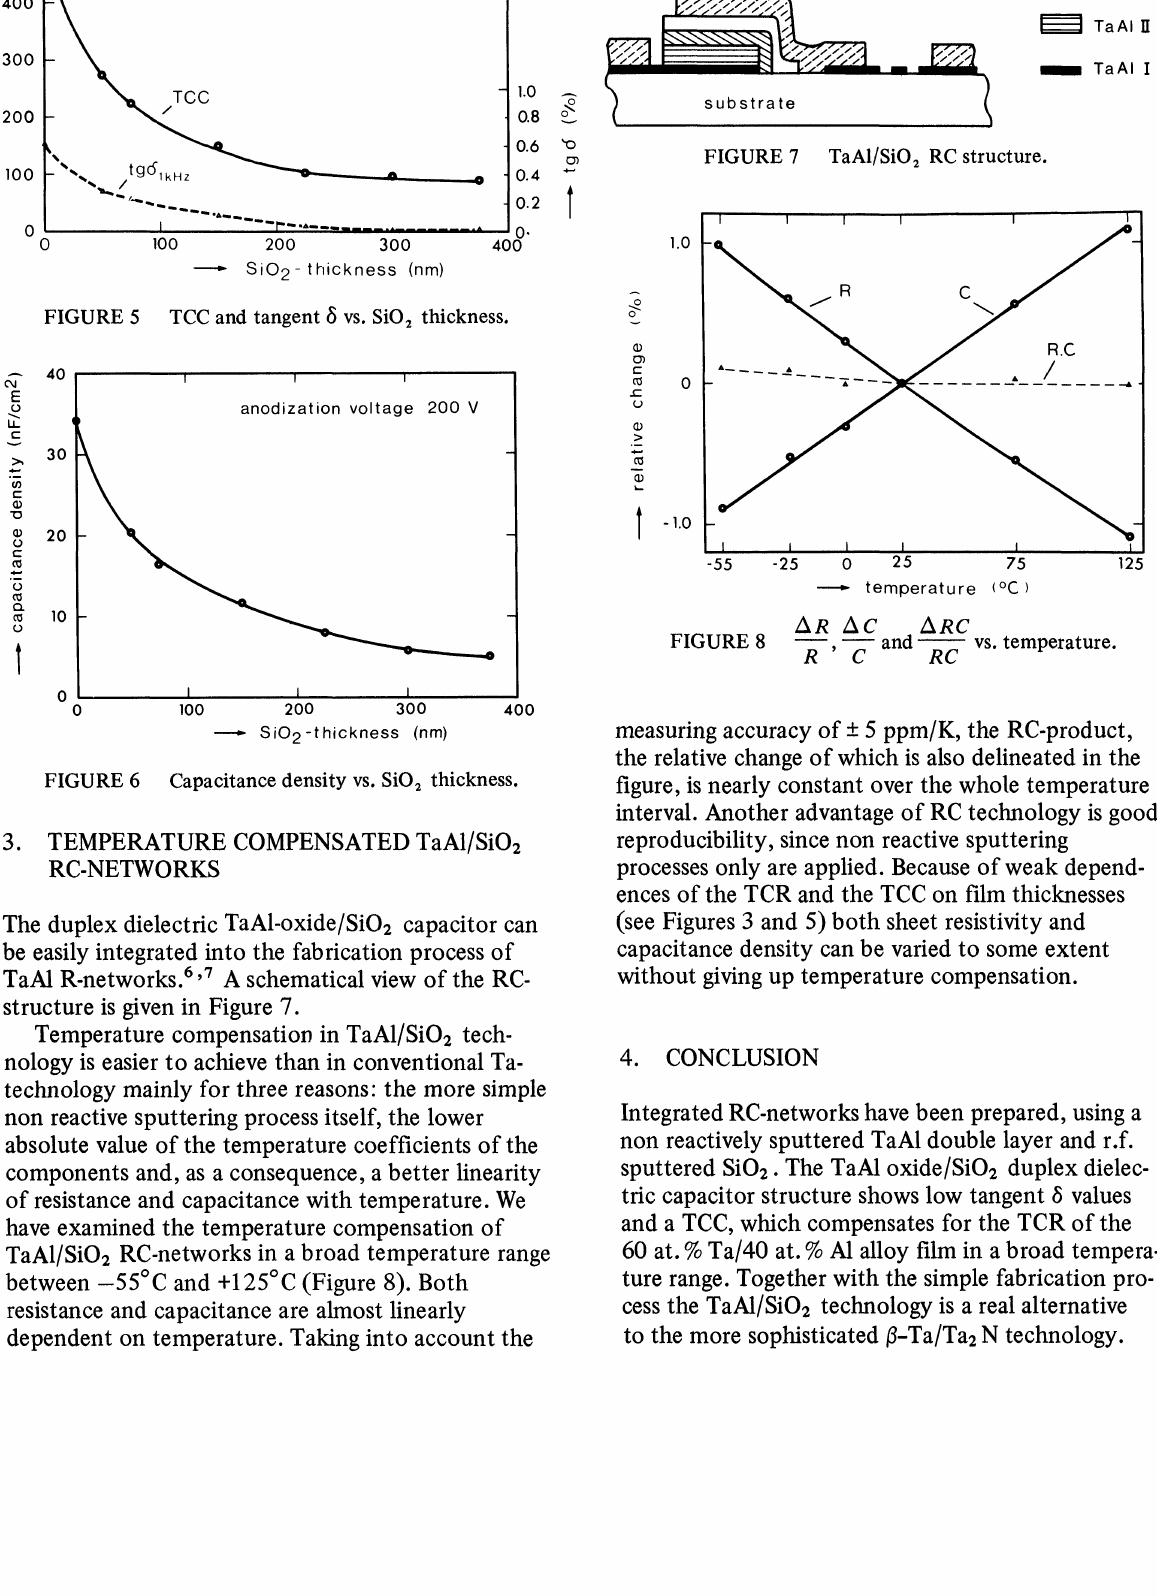
TaA1/SiO2 RC structure. FIGURE 7